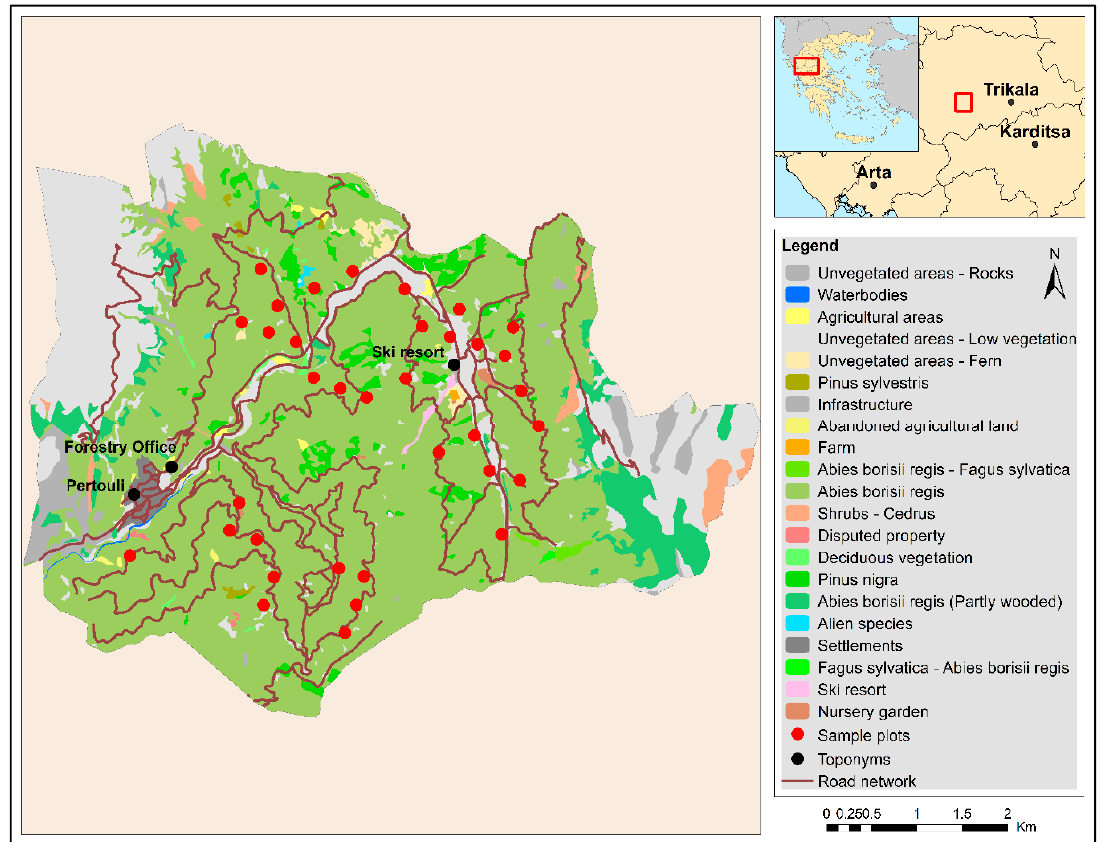
Figure 1. Map of the study area including sample plots location, road network, and vegetation cover map (vegetation map source: forest management plan, year 2018).